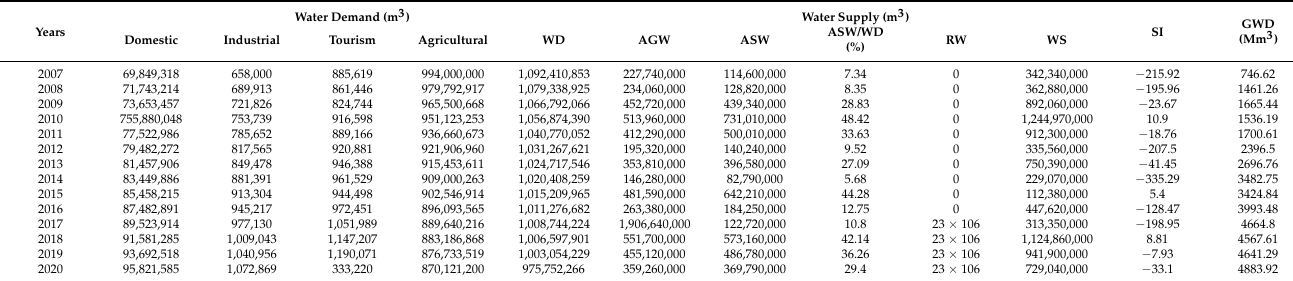
Table 2. Summary of System Dynamics model results.